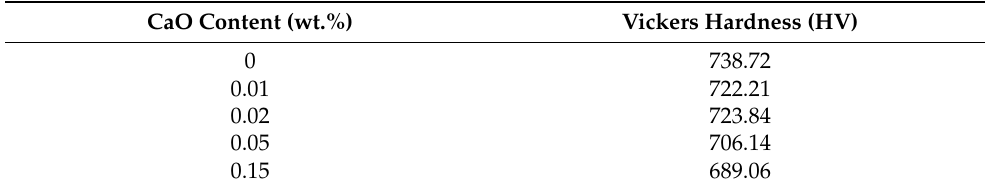
Table 1. Mechanical property of Y 2 O 3 ceramics with different CaO content.